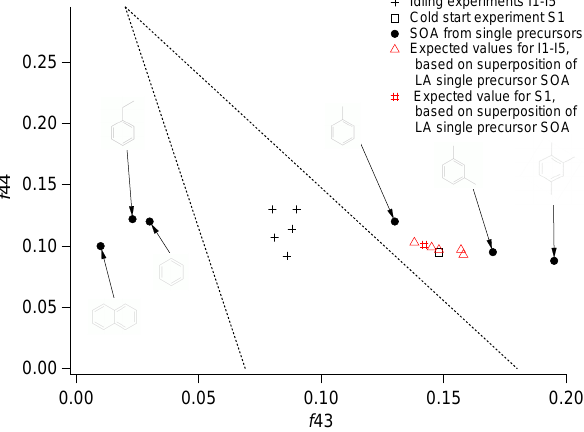
Fig. 8. The f 43 and f 44 for experiments I1–I5 ( + ) and for SOA formed from single precursors plotted together with the triangle from Ng et al. (2010). Also plotted are expected values for I1–I5 if only LA contributed to SOA formation, assuming superposition of the mass spectra for single precursor SOA. For experiments I1 and S1, a correction had to be made due to non-negligible POA contribution to OA. The f 44 to f 43 of SOA from precursors fea- tured in the figure are retrieved from the following sources: ben- zene (Ng et al., 2010), toluene (Chhabra et al., 2011), ethylbenzene (Sato et al., 2010), m-xylene (experiment P2, this study), 1,2,4- trimethylbenzene (derived from exp. P1) and naphthalene (Chhabra et al., 2011). The results suggest no more than 60% of SOA in I1–I5 were due to C 6 –C 9 LA precursors, assuming that the MS of gaso- line exhaust SOA can be estimated as a weighted mean of the MS of SOA from single precursors. See Table S4 (in the Supplement) for more details about these